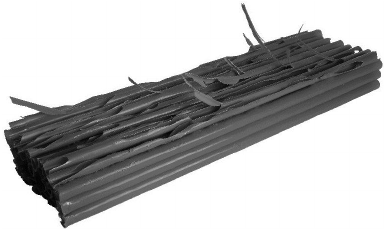
Figure 8. Tubular plastic wood model after a serrated tool was drawn across its surface.